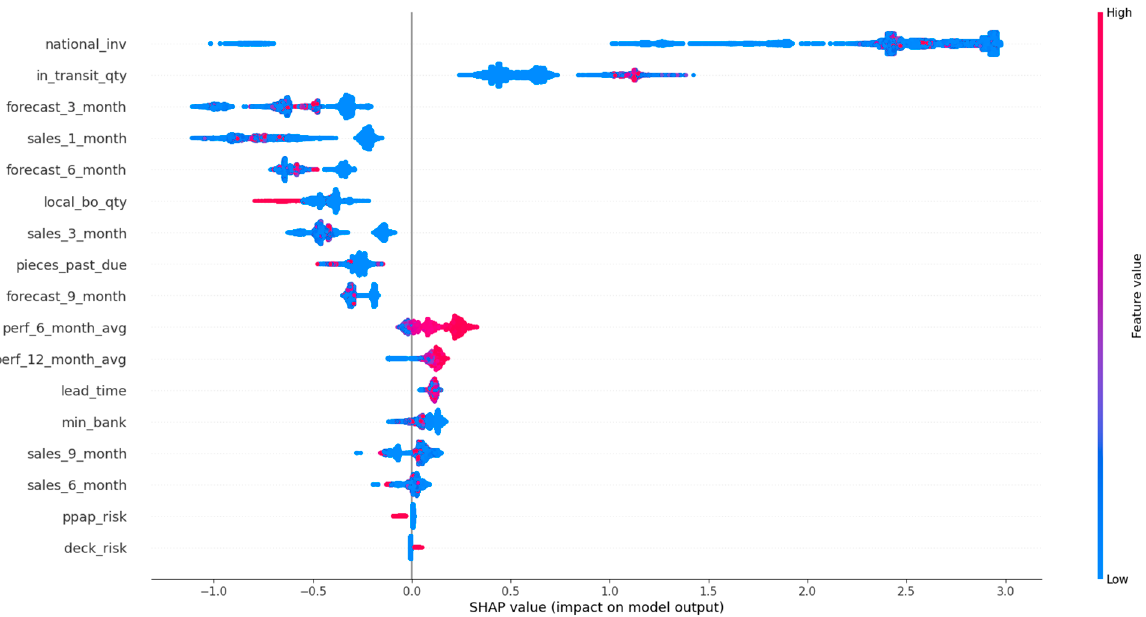
Figure 6. SHAP summary plot of LightGBM calibrated with the Isotonic Regression method.